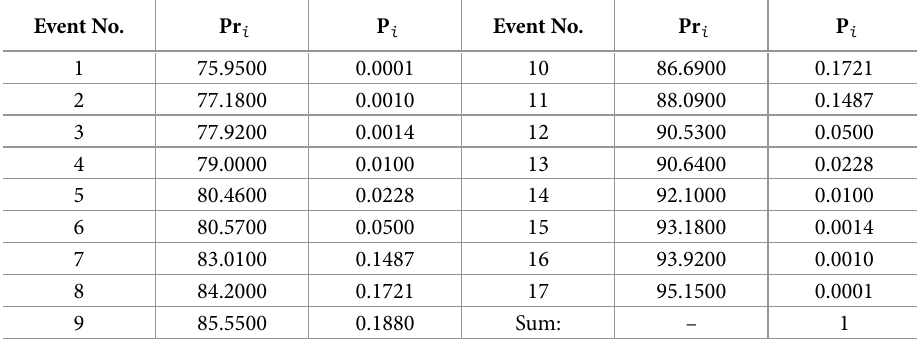
Table 6. Initial data for plotting statistical probability distribution line to obtain certain profit level Event